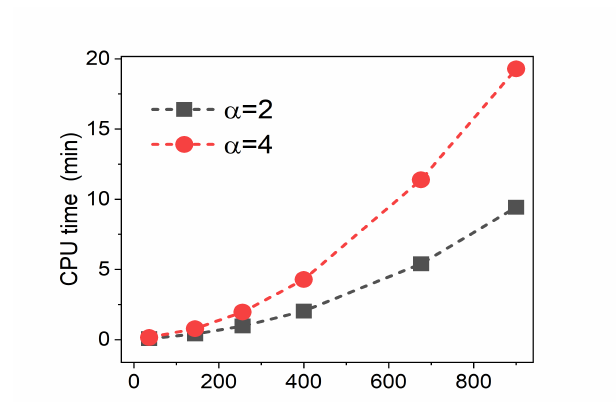
Figure 5: Time required for a single optimization step versus system size. The number of samples for the optimization is kept fixed to 2 × 10 4 for each data point. The sizes addressed are: N = { 36,144,256,400,676,900 } , where N is the number of spins. Simulations are performed in our local cluster machine exploiting 60 cores in parallel during the whole optimization process. The plot clearly shows that for fixed α the scaling is quadratic in the number of